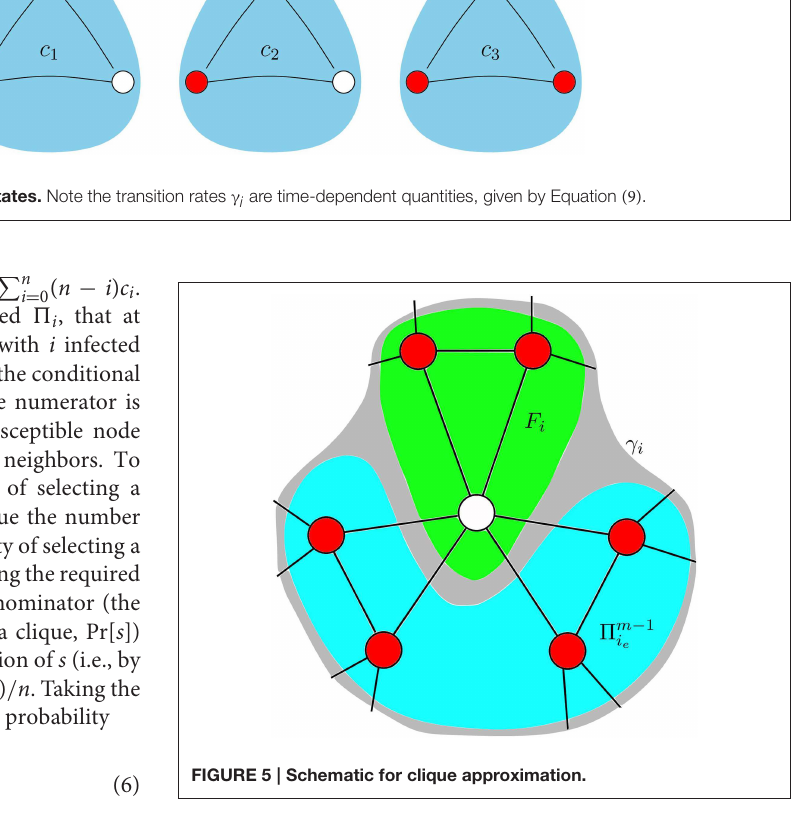
FIGURE 4 | Transition of a clique, with n = 3 , between states. Note the transition rates γ i are time-dependent quantities, given by Equation (9) .